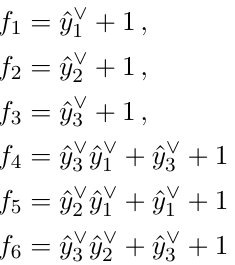
Figure 14. The dual polytope of the asymptotic scattering diagram in figure 8. Each asymptotic chamber corresponds to a vertex and walls between asymptotic chambers correspond to 1-dim